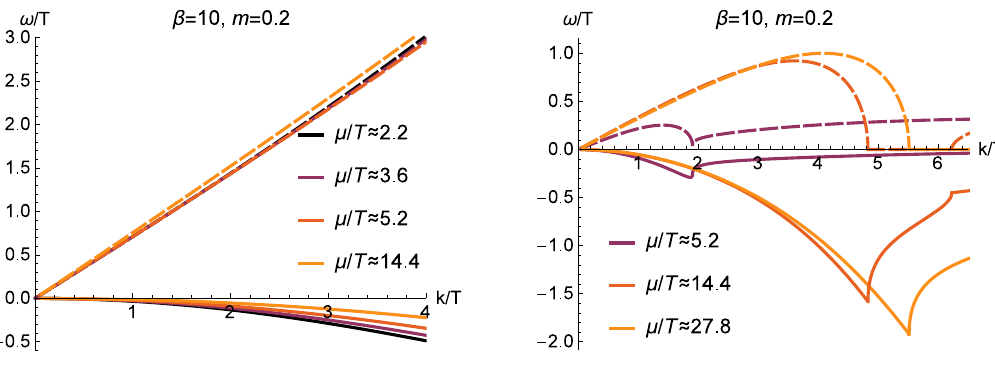
Figure 18 . The linear QNM (left) and ‘cloud’ CM (right) at (cid:12) = 10 and m = 0 :